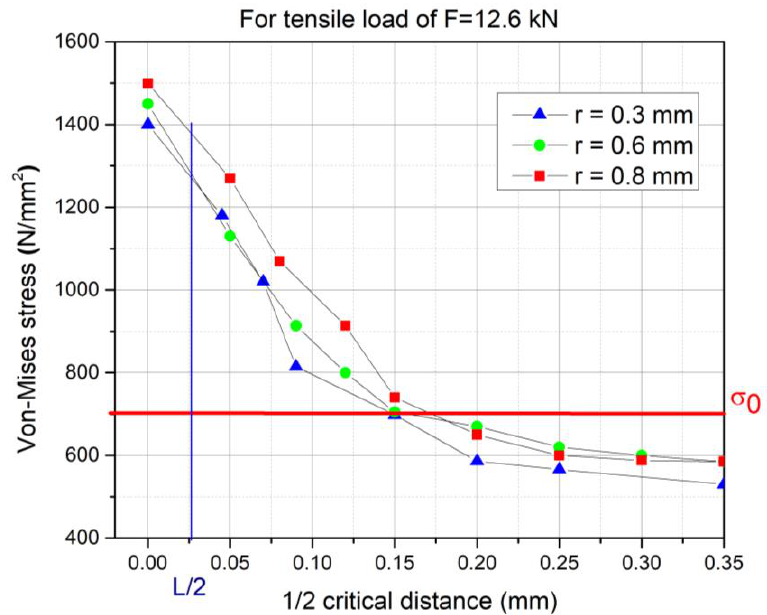
Figure 13. Comparative diagram of stress gradients and TCD method implementation.